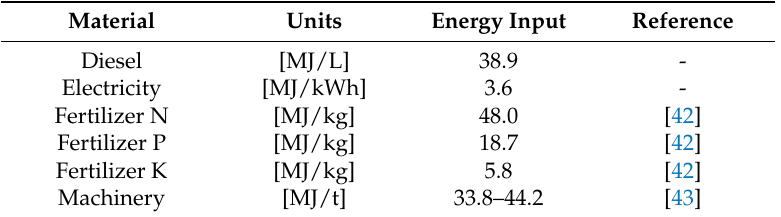
Table A3. Specific energy inputs of selected production means required for the cultivation and harvesting of wheat grain and straw.